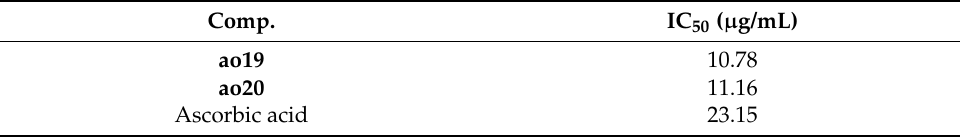
Table 64. In vitro antioxidant activity of the synthesized compounds ( ao21 – ao22 ).